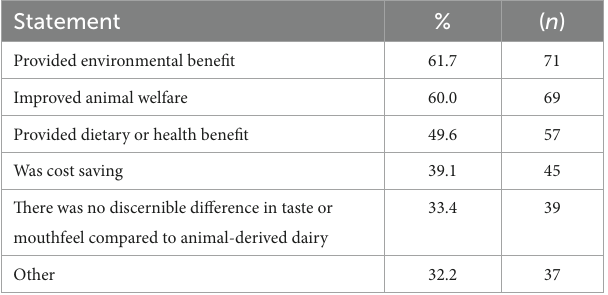
(Table 4). Adjusting for all other predictors (gender, knowledge of food systems, education), this analysis showed that being 35 years of age or older, and being vegan, were negatively associated with having positive feelings towards yeast-derived agriculture (chi-square (10) = 29.086, p = 0.001). Being age 35 years or older had the odds-ratio of 0.151 (95% CI: 0.045, 0.499) and being vegan had the odds-ratio of 0.344 (95% CI: 0.125, 0.943). Furthermore, individuals in this pilot study with a household income between $50,000-99,999, compared with individuals with household income of $49,999 or less, were also negatively associated with having positive feelings towards YDA and had an odds-ratio of 0.192 (95% CI: 0.045, 0.820).